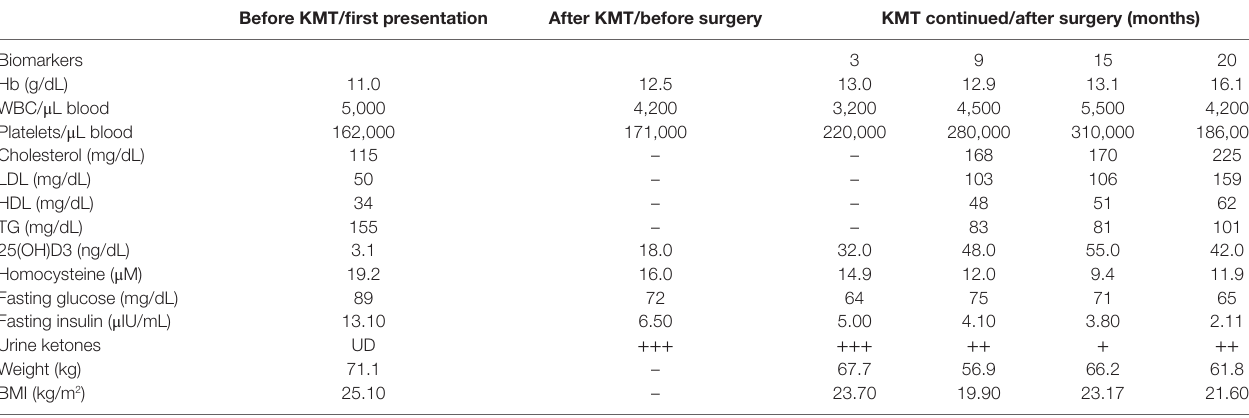
taBle 1 | Influence of ketogenic metabolic therapy (KMT) on the patient’s biomarkers. Before KMt/first